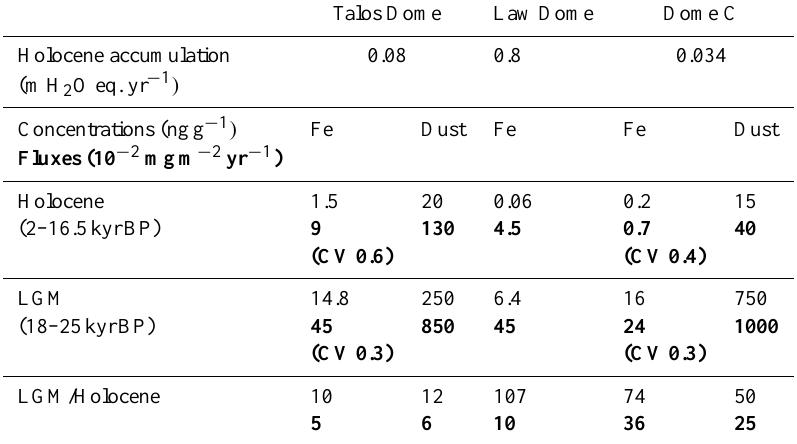
Table 1. Deposition of Antarctic Fe and dust before and after the last deglaciation. Talos Dome Fe data compared to EPICA Dome C (EDC) (Gaspari et al., 2006; Delmonte et al., 2010) and Law Dome (Edwards et al., 2006). Dust concentrations and fluxes are also shown for EDC and Talos Dome (Delmonte et al., 2010). Note that Fe and dust concentrations are shown in normal font while fluxes are shown in bold font. Coefficients of variability (CV) have been calculated for Talos Dome and EDC Fe fluxes. Indicative Holocene accumulation rates are also shown for comparative